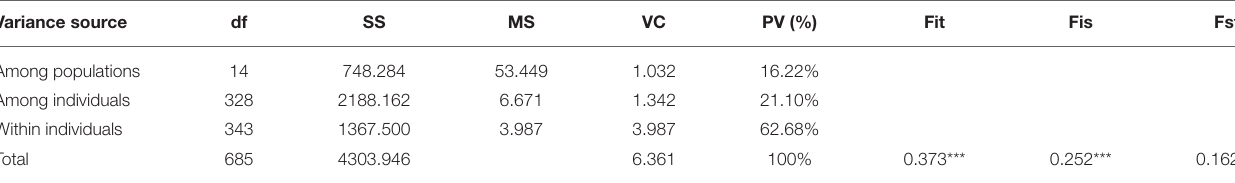
TABLE 5 | Analysis of molecular variance for the J. mandshurica population.